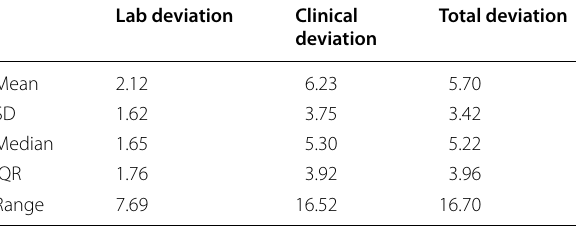
SD Standard Deviation; IQR interquartile range; Lab deviation : the deviation between the digital plan and the laboratory prototype; Clinical Deviation : the deviation between the laboratory prototype and the post-insertion position; Total Deviation : the deviation between the digital plan and the post-insertion position